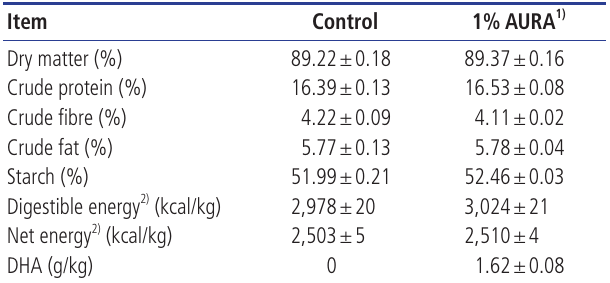
Table 2. Analytical characteristics of the finishing pig experimental diets on a dry matter basis